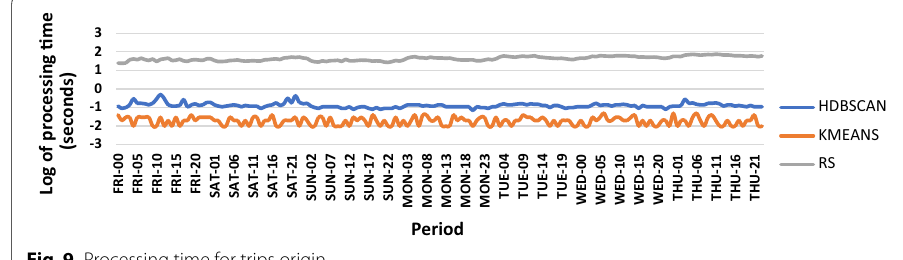
Fig. 9 Processing time for trips origin